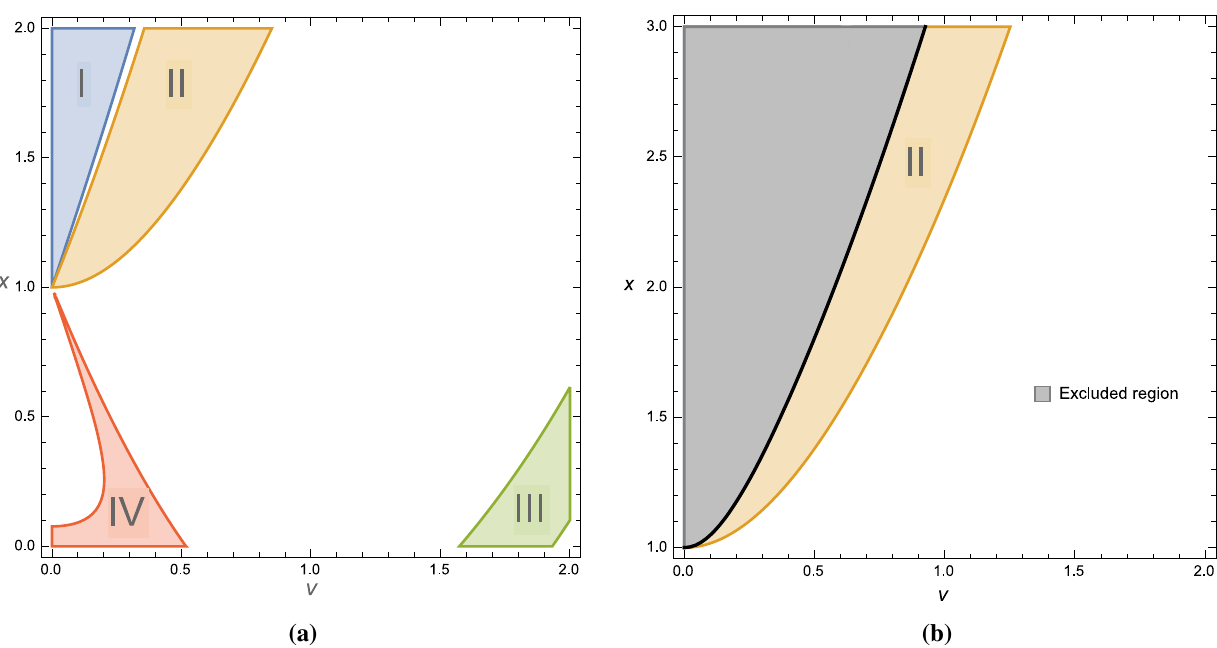
Fig. 1 a Allowed parameter space (v, x ) with 0 < v < 2 . 0 and 0 < x < 2 . 0. The colored regions in which A 2 > 0 can be divided into 4 parts, namely I, II, III and IV. b Region I and part of Region II are in the excluded area where v 2 − 1 condition is not